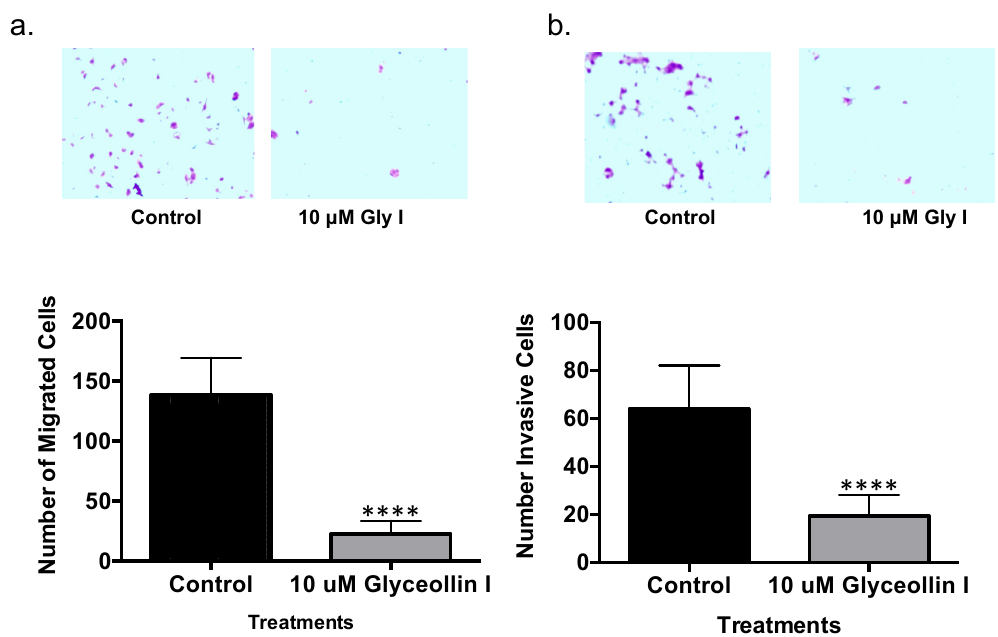
Figure 6. Glyceollin I inhibits the LTLT-Ca cell motility. ( a ) 2.5 × 10 4 cells were seeded in the upper chamber of a transwell insert (8 μ M pore size) alone (migration) or ( b ) coated with Matrigel ® (invasion). Cells were treated with 10 μ M glyceollin I or vehicle control at time of plating. Lower wells contained IMEM supplemented with 10% CS-FBS. After 24 h, migrated or invaded cells were fixed and stained for visualization. Upper panels are representative images of crystal violet stained migratory cells. Results are expressed as the mean unit ± SEM (**** p < 0.0001; *** p < 0.001; ** p < 0.01; * p < 0.05) of four independent experiments in triplicate.